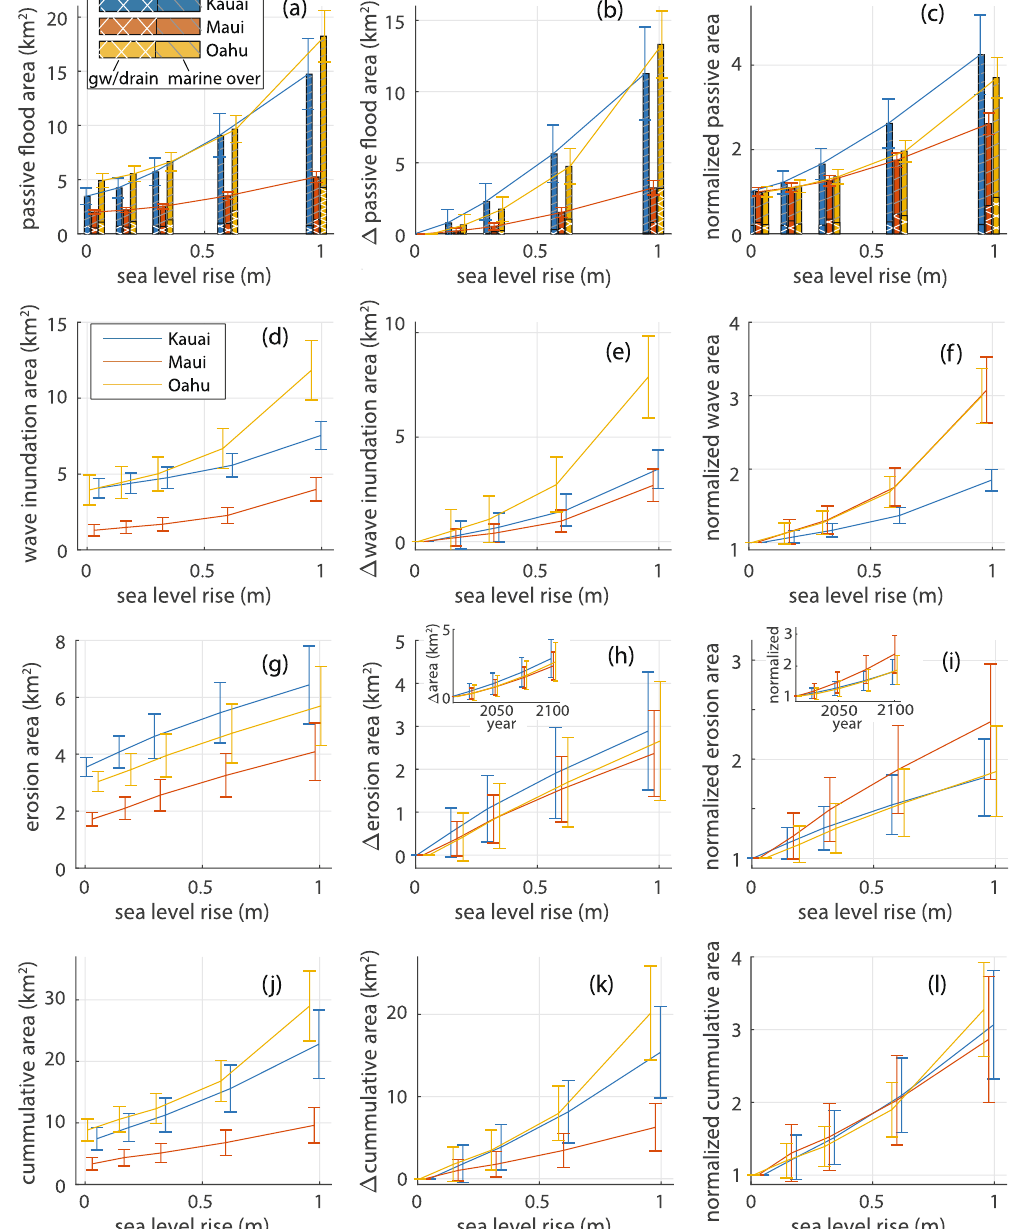
Figure 3. Quantification of land area exposed to each hazard due to increased SLR is shown for the islands of Kaua‘i (blue), Maui (yellow), and O‘ahu (red) for the SLR scenarios: present-day (0.08), 0.17, 0.32, 0.60, and 0.98 m. Plots show: (left column) exposed areas; (middle column) change in exposed area relative to the present-day scenario (future area minus present-day area); and (right column) normalized area (future area divided by present-day area). Error bars represent standard errors. Land areas exposed to passive flooding ( a – c ) are shown as stacked histograms, where the height of each bar represents the total (passive marine overland + groundwater/drainage) land area exposed, with marine overland contributions shown with gray single-hatching and groundwater/storm drain contributions shown with white cross-hatching. Wave inundation areas are shown in ( d – f ). Land areas exposed to erosion are shown in ( g – i ); insets show acceleration in areas exposed to erosion, when plotted versus time. The cumulative area ( j – l ) is the area exposed to one or more